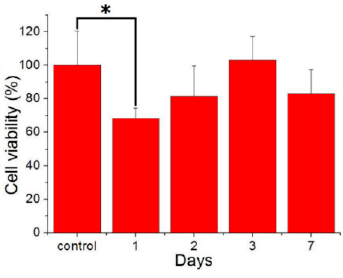
Figure 9. Cell viability of the fluconazole-incorporated beads (* p <